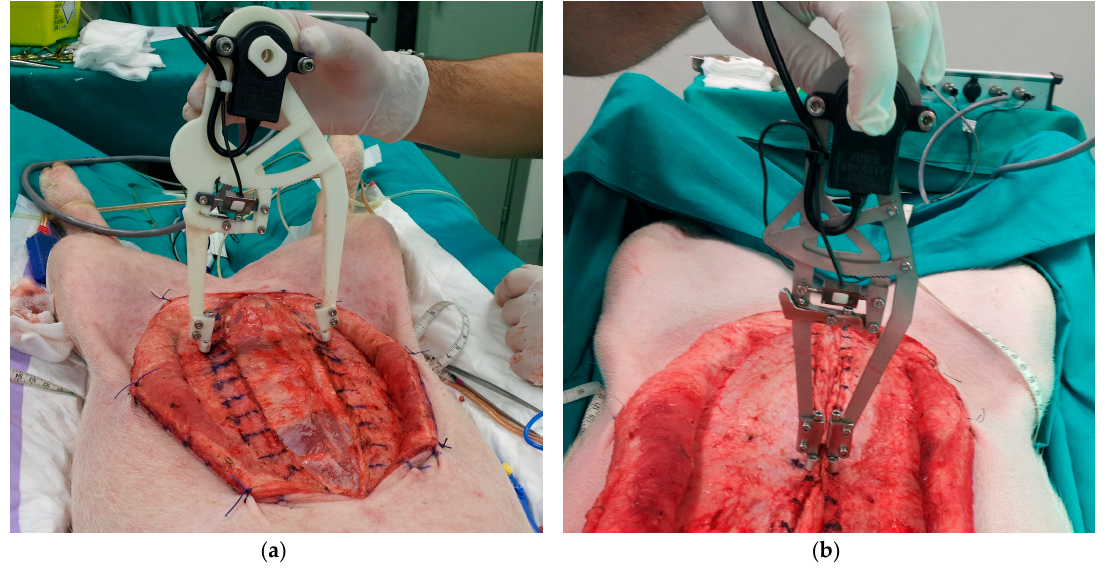
Figure 12. Measuring in experimental surgery with the: ( a ) 3D printed plastic prototype; ( b ) stainless steel prototype.